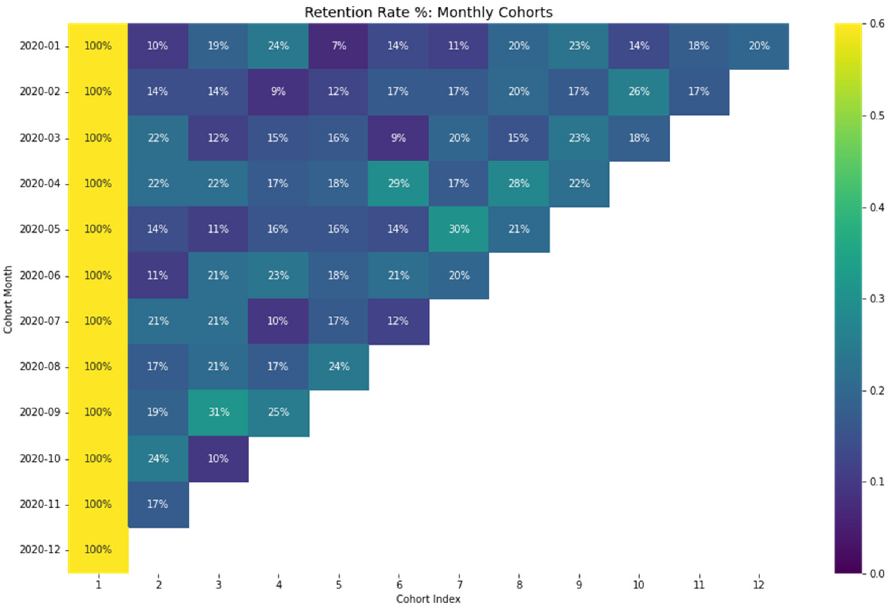
Figure 12. Standardized e-commerce awareness score distribution by age range for Reliability as- pect.